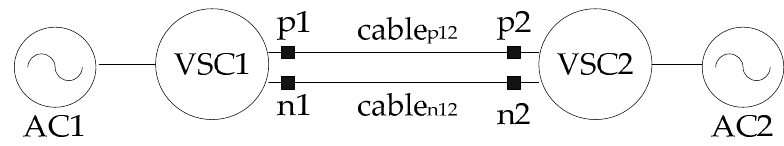
Figure 3. Schematic of the voltage-source converter-based high-voltage direct current (VSC-HVDC) system.